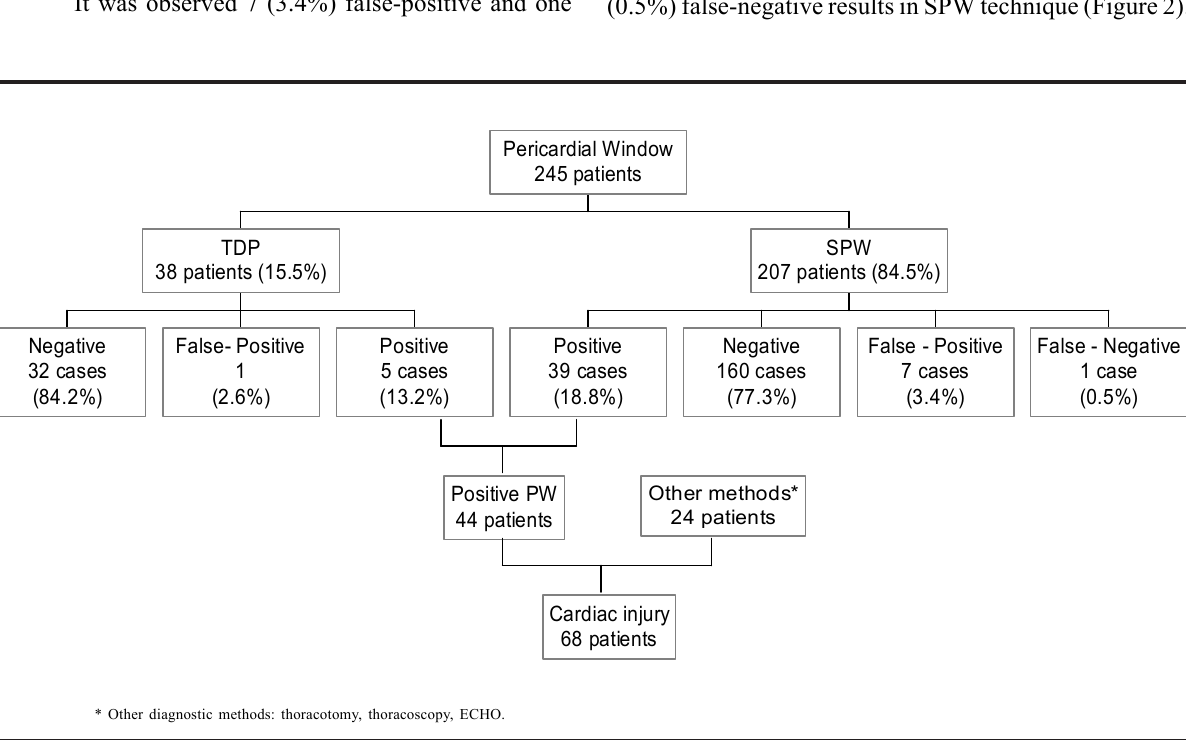
However, the TDP procedure had showed one (2.6%) false-positive and no false-negative results. All eight